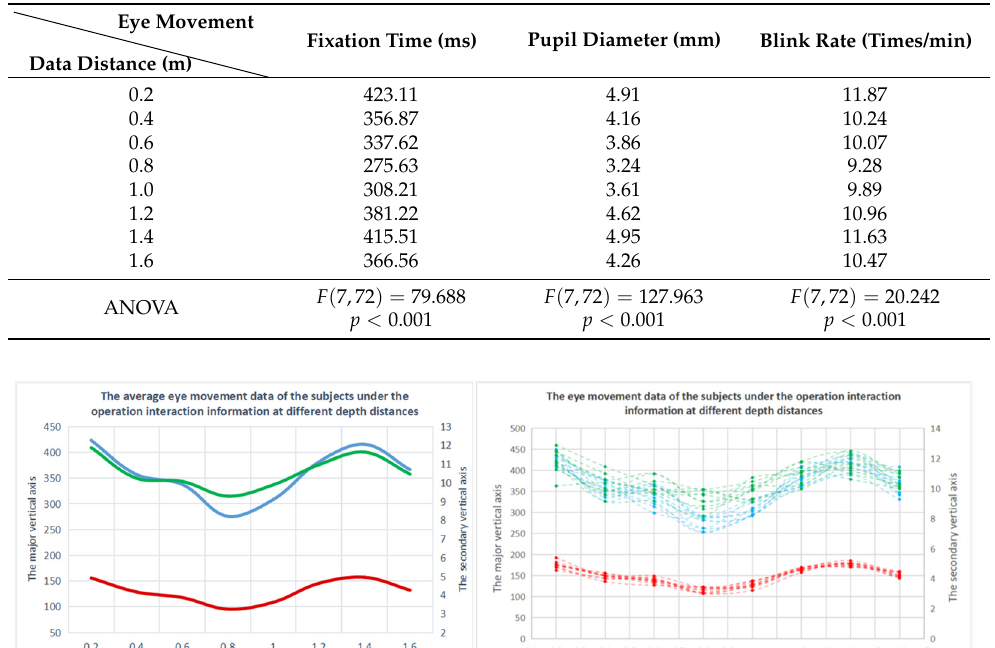
Table 5. Average eye movement data after dividing the depth and distance range of operation interaction information.